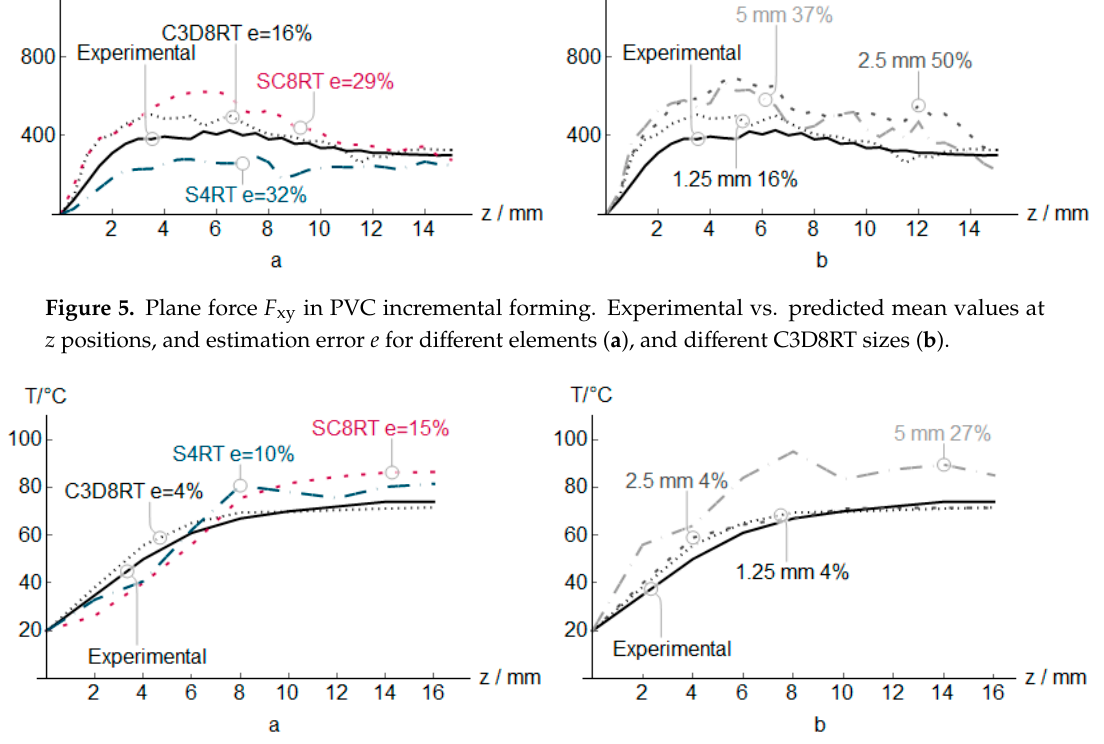
Figure 6. Temperature in PVC incremental forming. Experimental vs. predicted values at z positions, and error e for different elements ( a ), and different C3D8RT sizes ( b ).